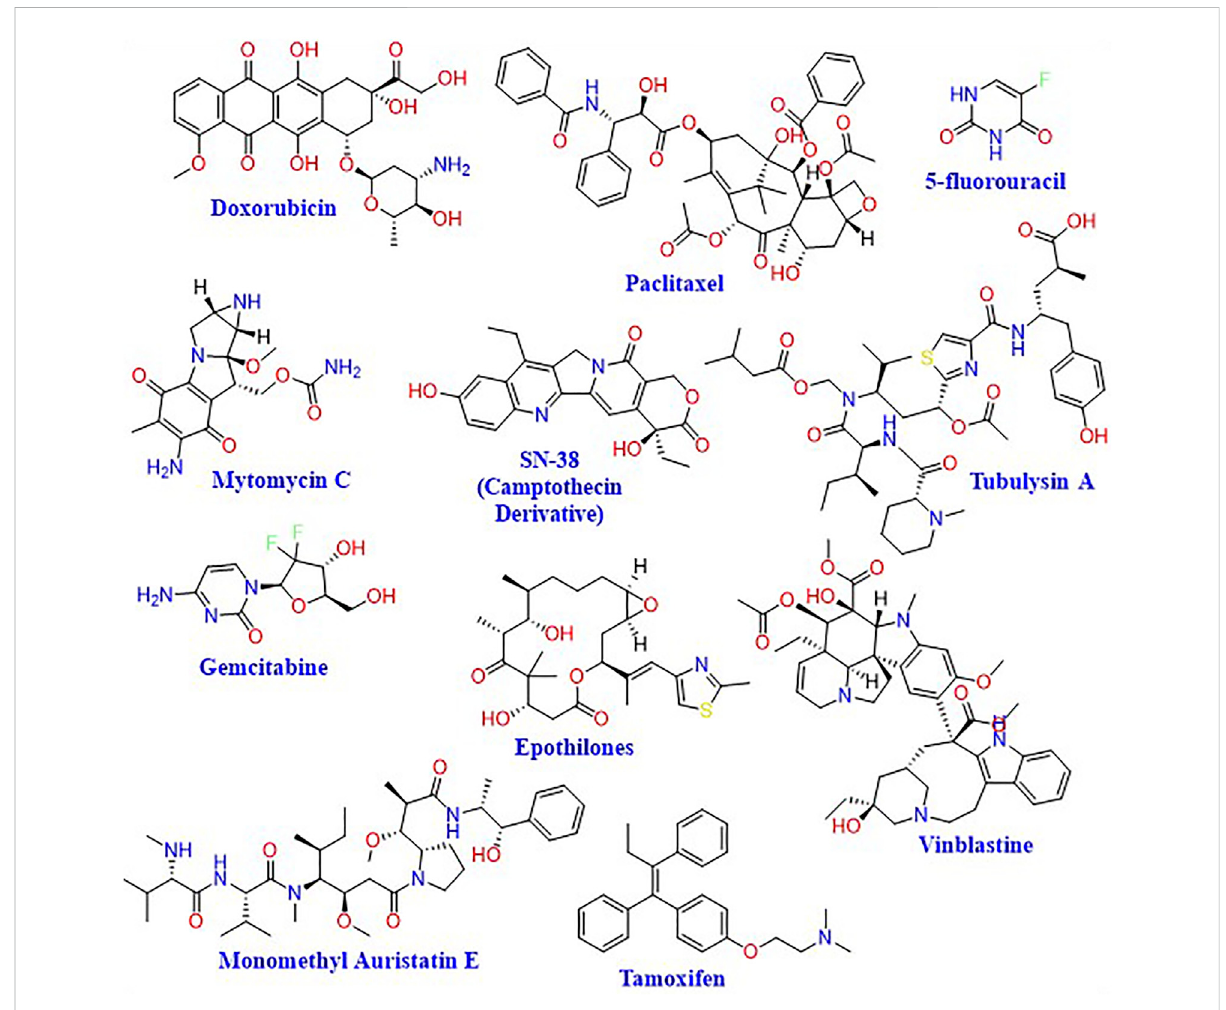
FIGURE 4 Chemical structures of representative cytotoxic agents used in